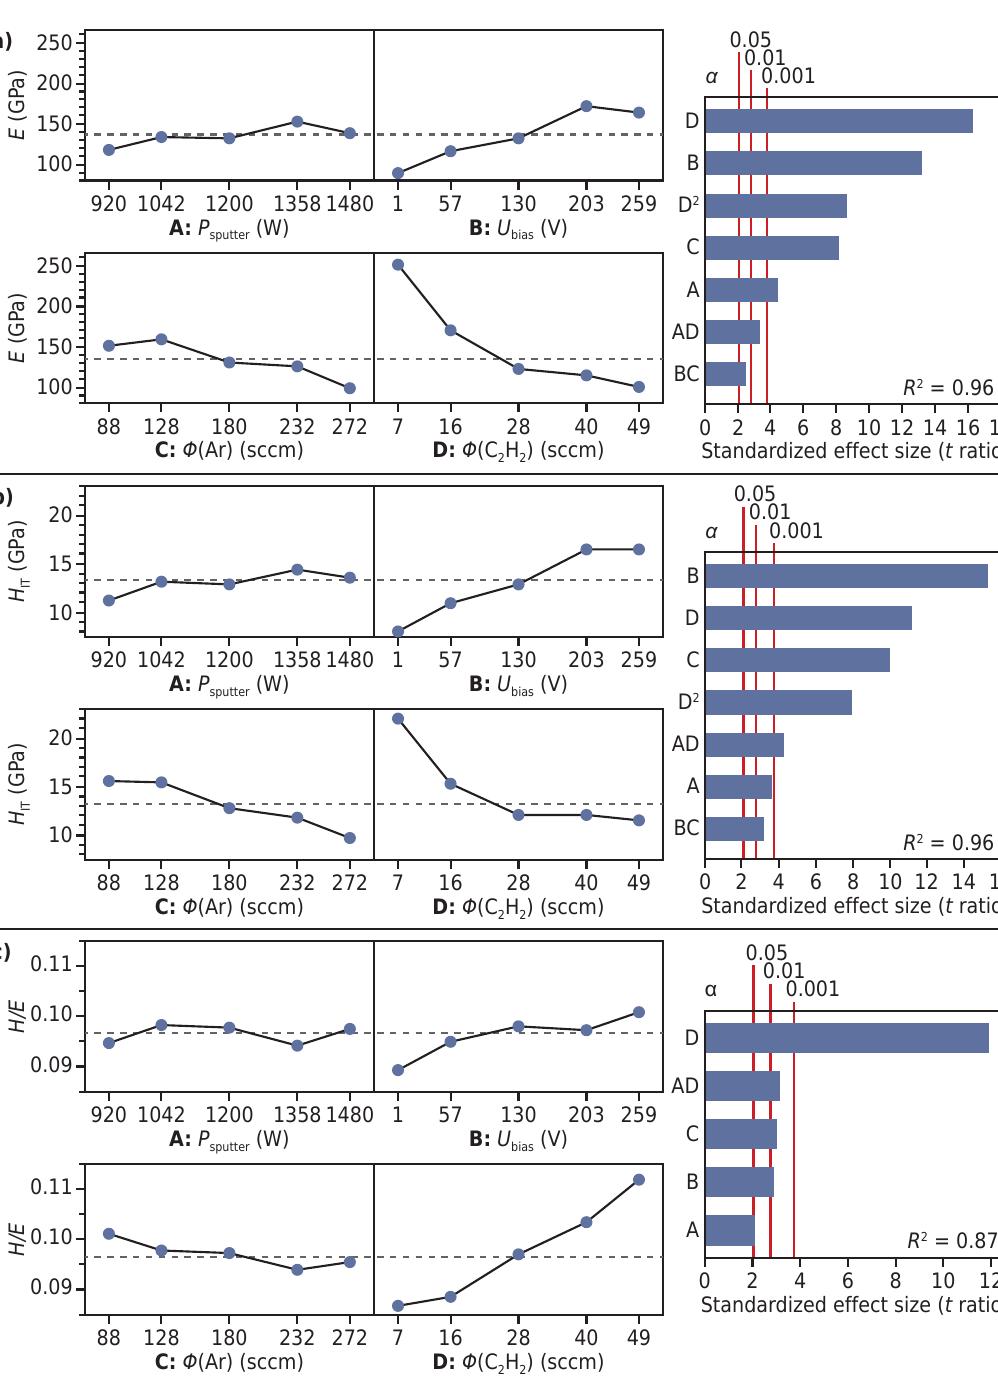
Figure 8. Main effect plots and Pareto charts of standardized effects showing the relationship between the varied deposition parameters and the mechanical properties of the